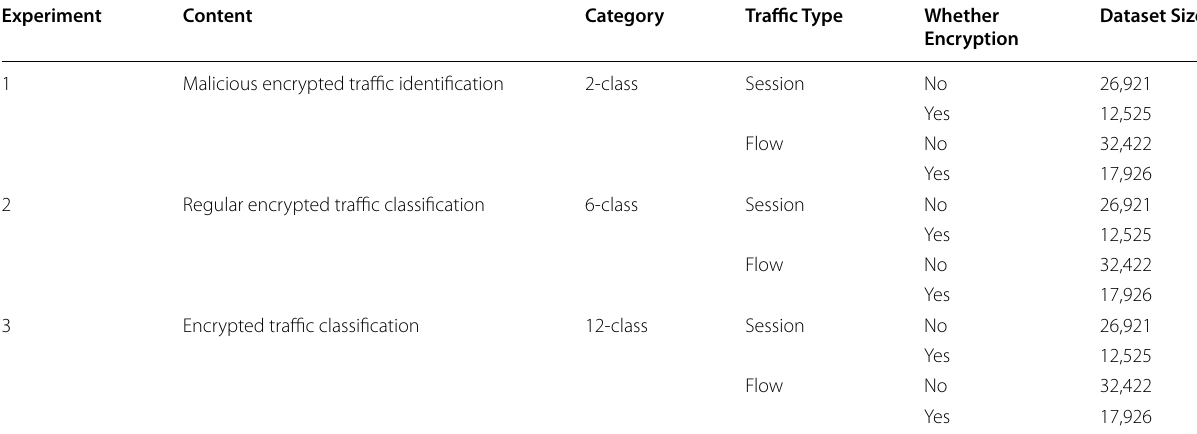
Table 2 1D-CNN comparison experiment table